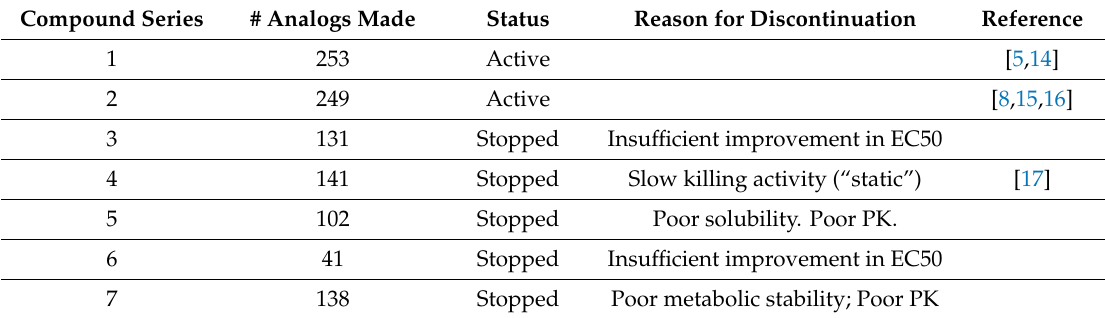
Table 2. Summary of progress in hit-to-lead campaigns for the 12 compound